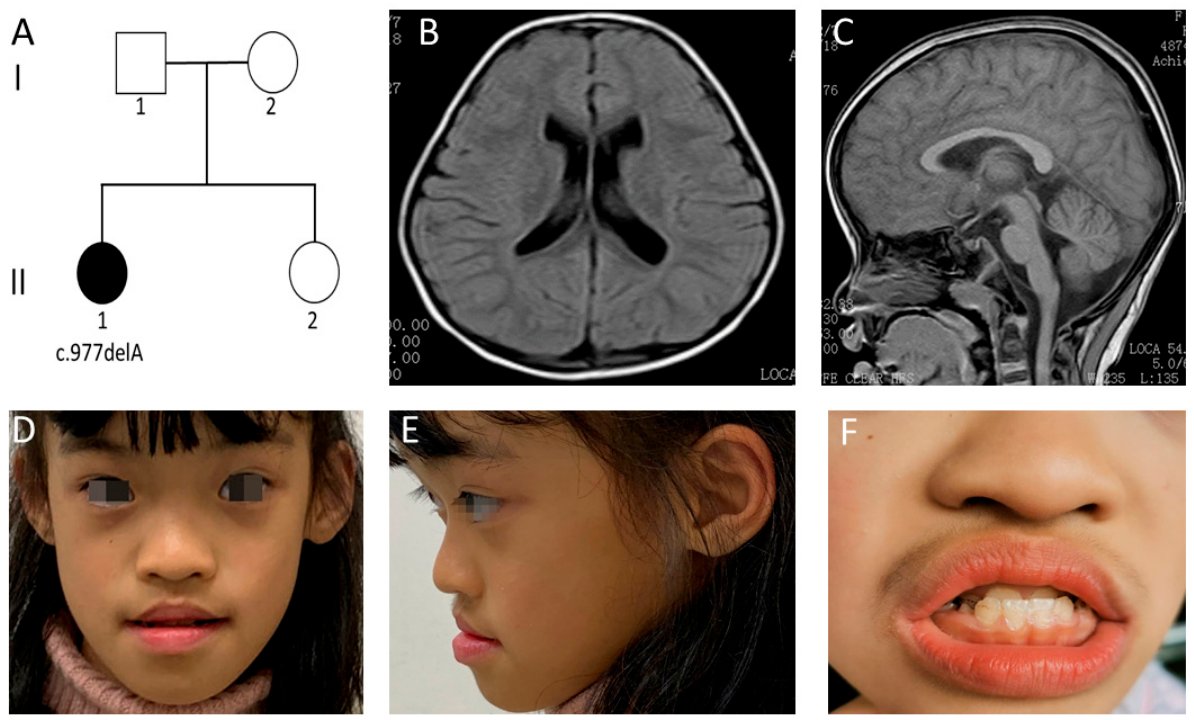
Figure 1. Clinical manifestations and auxiliary examinations of the case 1. ( A ) Family pedigree of case 1. ( B , C ) Brain MRI scans demonstrating mild enlarged ventricles and an absence of other structural brain anomalies (T1-weighted image). ( D – F ) Distinctive facial features were identified. These included arched eyebrows, rounded palpebral fissures, a depressed nasal root, full nasal tip and anteverted nares. She had a wide mouth, decreased Cupid’s bow, short philtrum, full lips, an anterior reverse bite, enamel hypoplasia, widely spaced teeth, and abnormal gums.